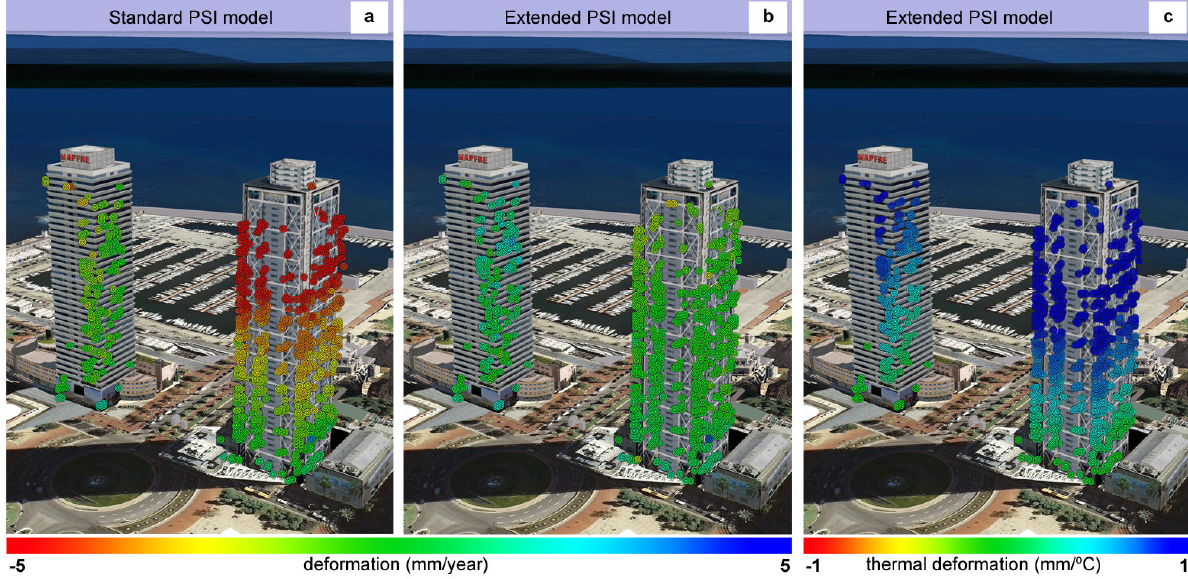
Figure 2. Geocoded deformation velocity maps estimated from 16 COSMO SkyMed images using the (a) standard PSI model and the (b) extended PSI model, and geocoded thermal map (c). The maps are superimposed over a Google Earth image (© 2009 Google, Institut Cartogràfic de Catalunya).